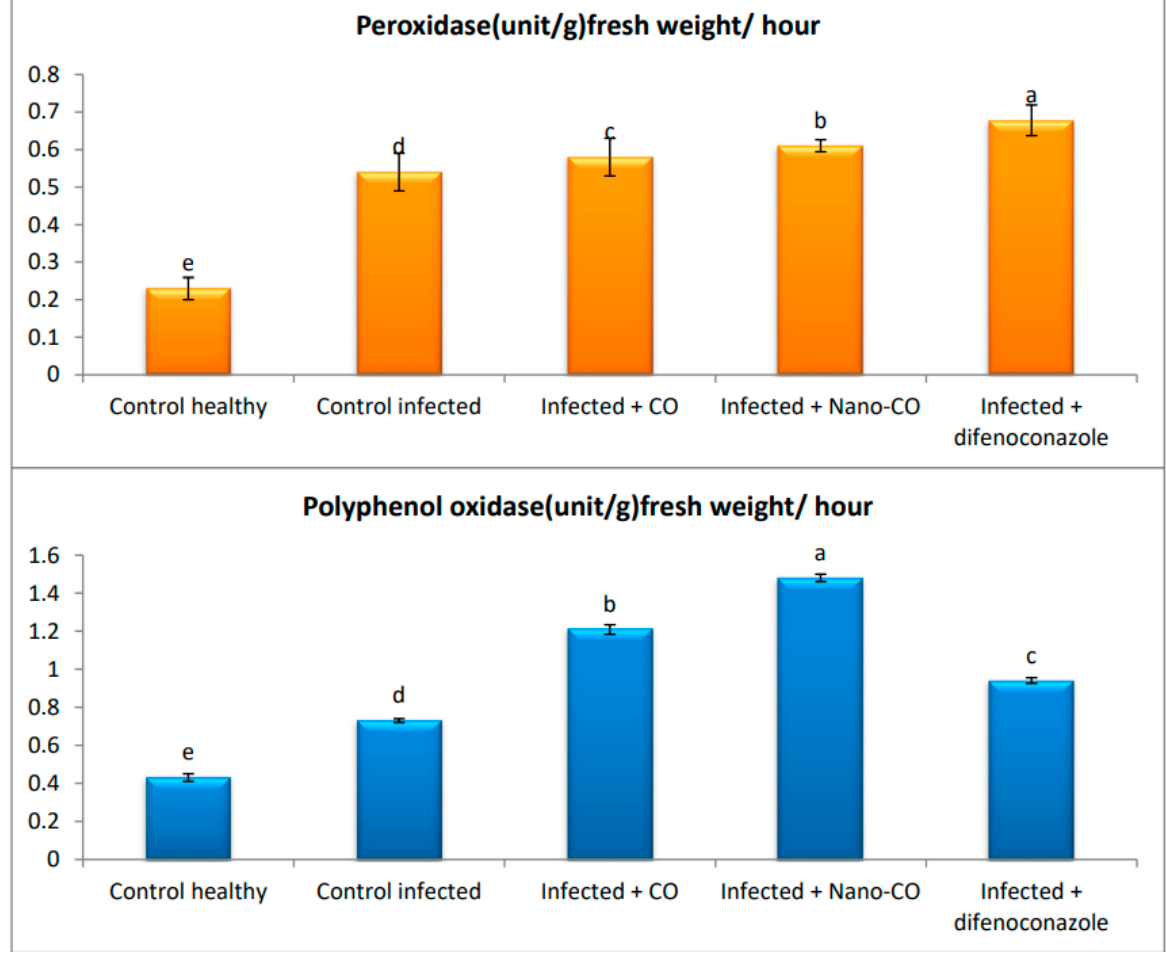
Figure 9. E ff ect of CEO and CEONE on PPO and POD content of Carum carvi. Le tt ers a,b,c,d,e mean Figure 9. Effect of CEO and CEONE on PPO and POD content of Carum carvi . Letters a,b,c,d,e mean power of signi fi cance. power of